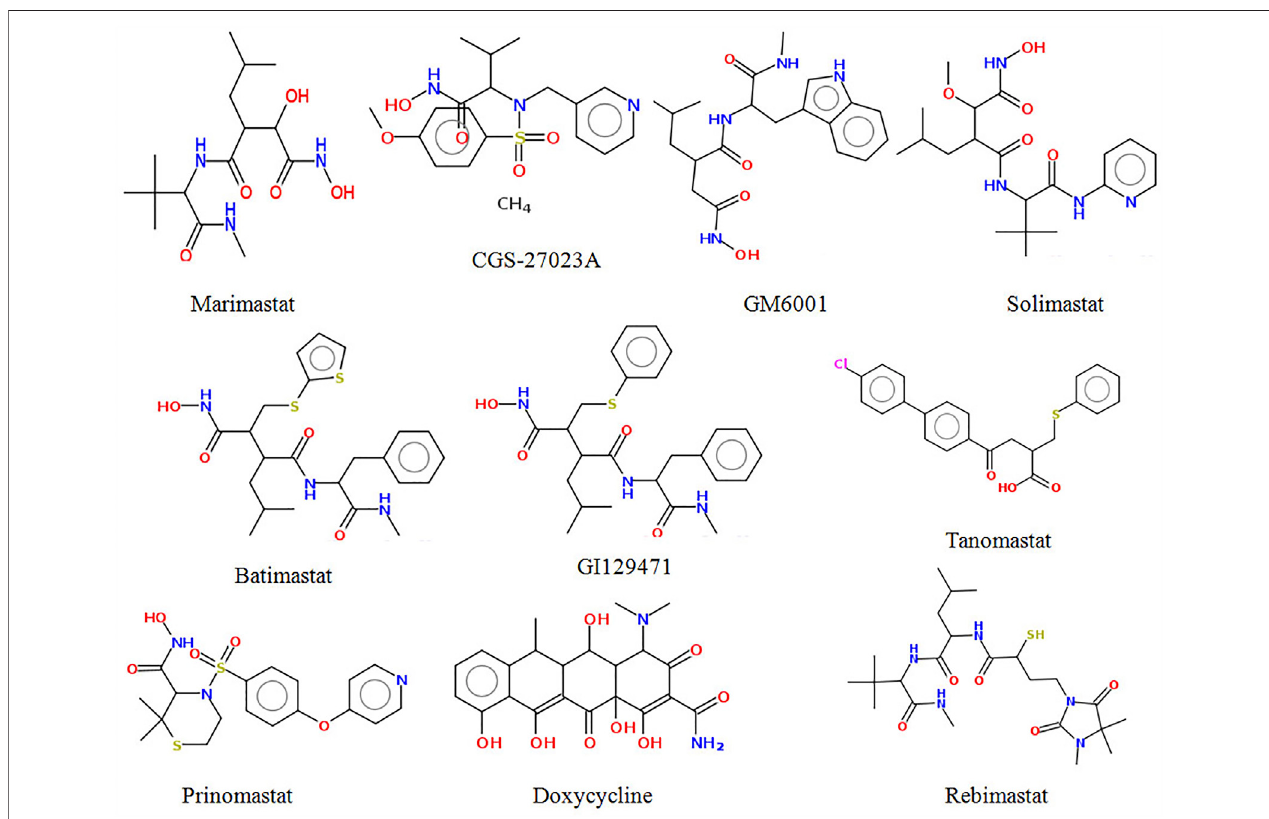
FIGURE 1 | Structure of some potent MMP-9